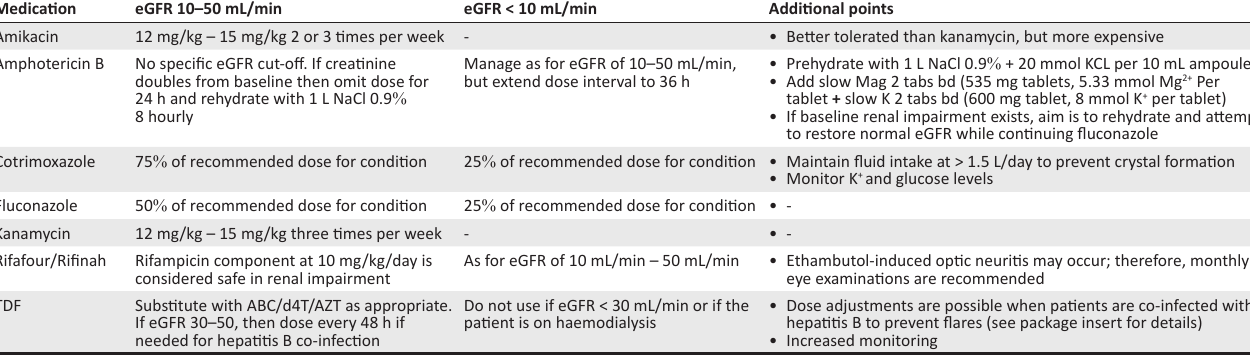
TABLE 4: Medication adjustments in acute kidney injury and/or chronic kidney disease.